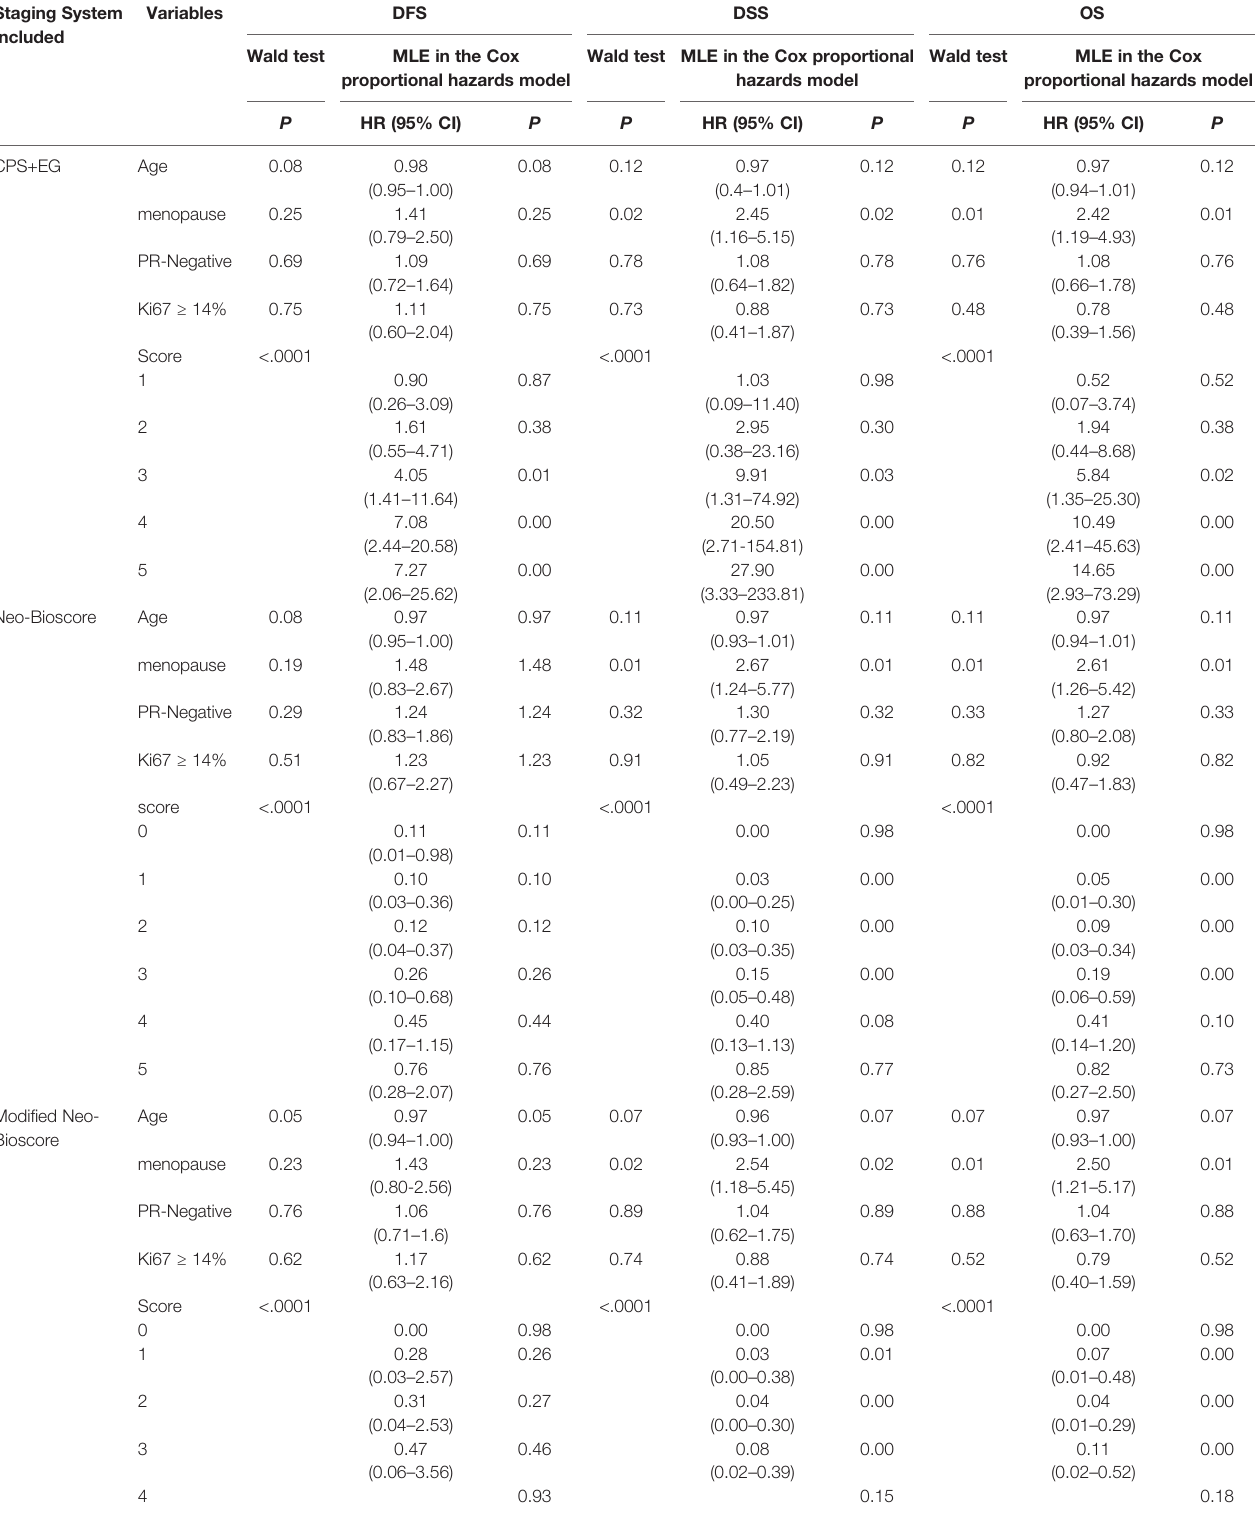
TABLE 5 | Multivariate Analyses Using Wald test and Maximum Likelihood Estimation (MLE) in Cox Proportional Hazards Model. Staging System